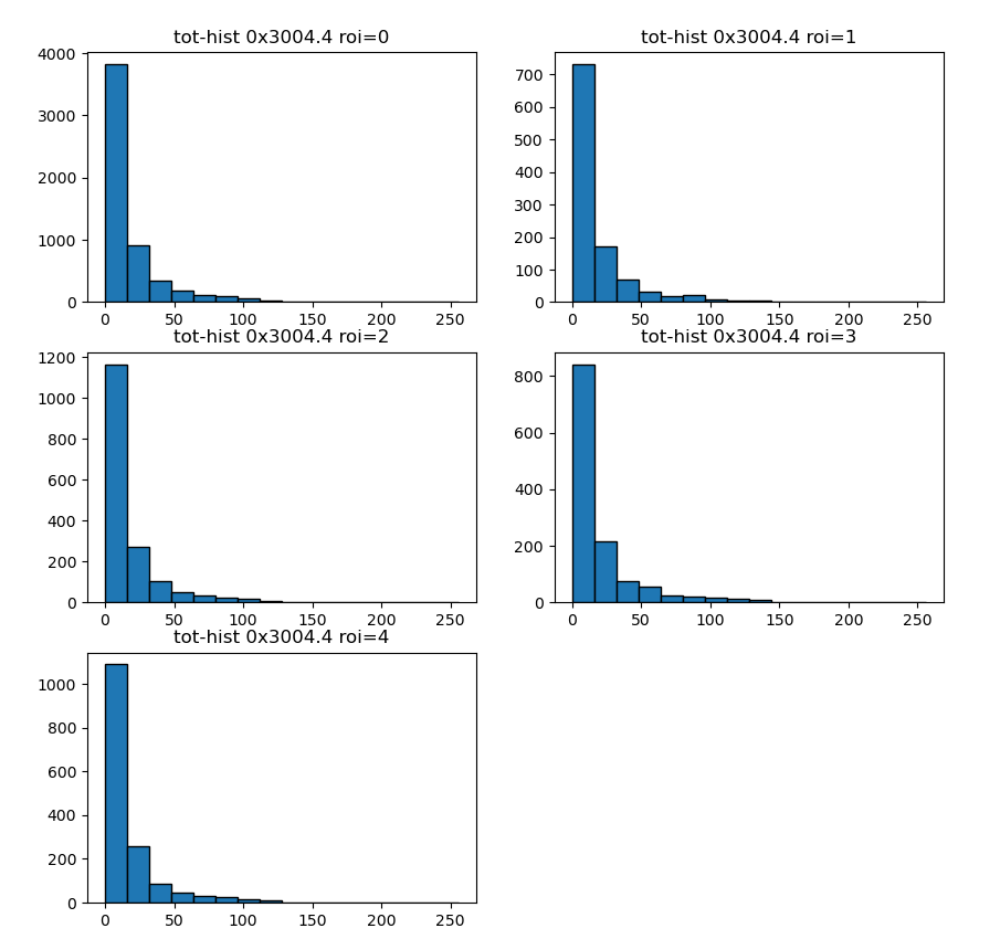
Figure 12. Deposited energy spectra of registered particles from a 241-Am source. Results are given for the data used in Figure 11. The distributions are shown for the entire area of the pixel detector (ROI = 0, top left) and separately for the four distinct optical-collimator segments (labeled ROI = 1 thru ROI =